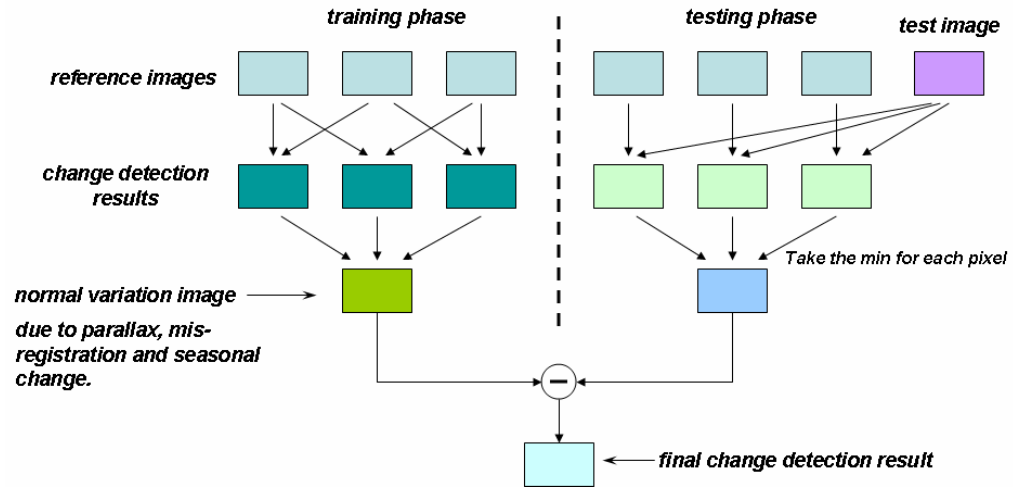
Figure 4. Signal flow in MRCD.